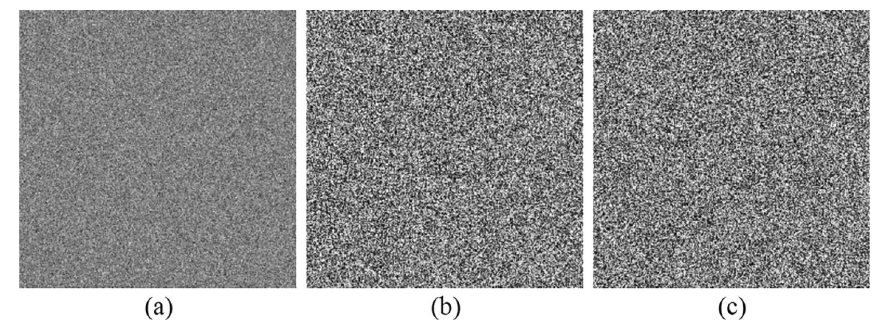
Figure 11. ( a ) Bob’s secret key k b ′ ; ( b , c ) are ( K B ⊕ k b ′ ⊗ K A ) , generated in Bob’s